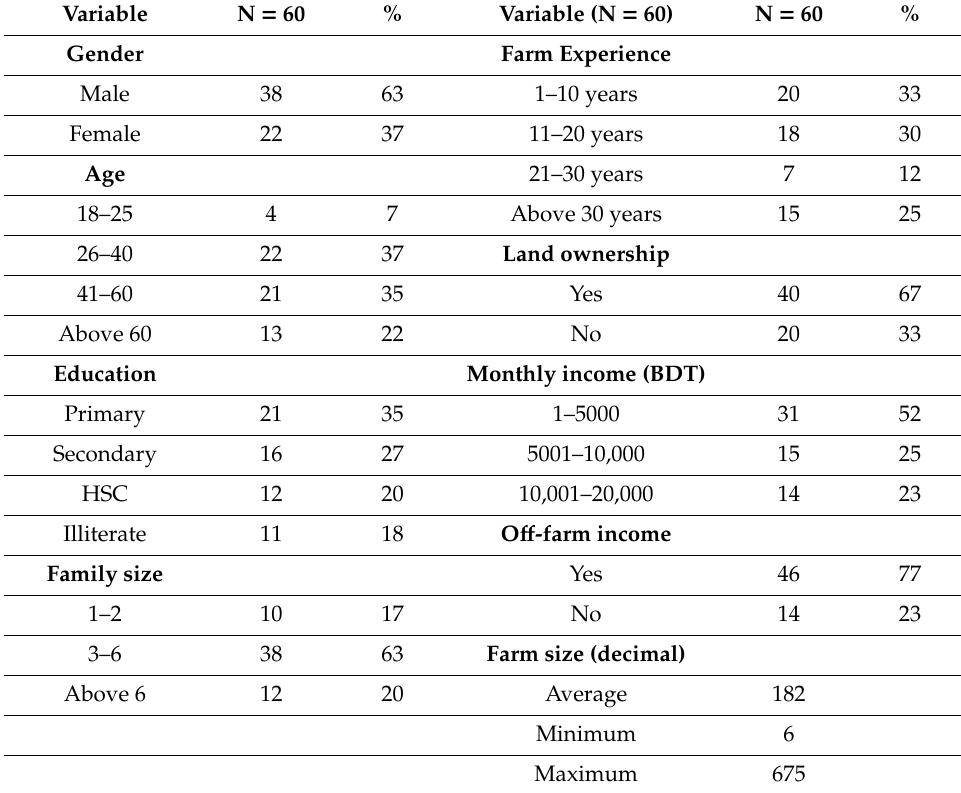
Table 1. Descriptive statistics of the respondents (Source: Baseline